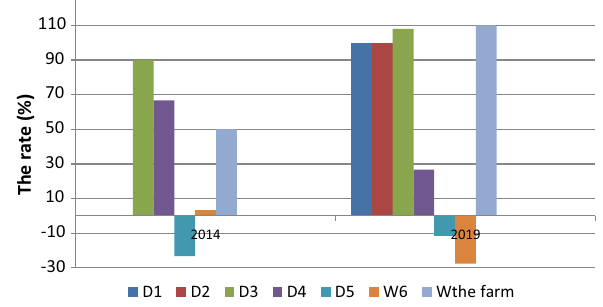
Fig.10 The rate of change in K + between 2014 and 2019